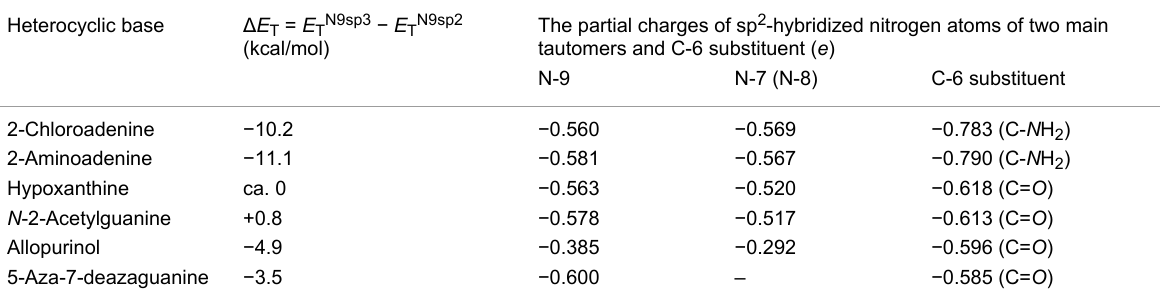
Table 2: The geometry optimization of the two main tautomeric structures of heterocyclic bases studied by means of the restricted Polak–Ribiere ab initio method (6-31G** level; basic set of parameters; HyperChem 8.1). Heterocyclic base The partial charges of sp 2 -hybridized nitrogen atoms of two main tautomers and C-6 substituent ( e )